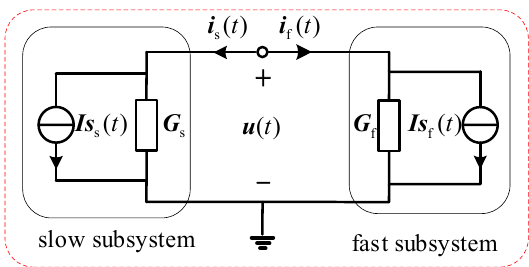
Figure 4. The simulation diagram based on the Norton equivalent circuit.